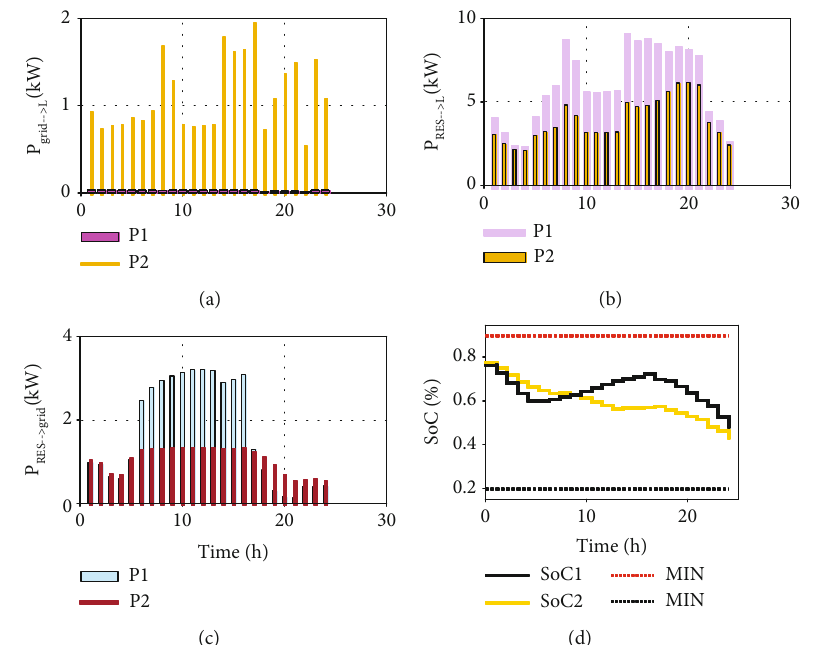
Figure 12: (a) Imported power from the grid to supply the load; (b) generated power from RES to the load; (c, d) RE power injected into the grid and SoC of the battery,